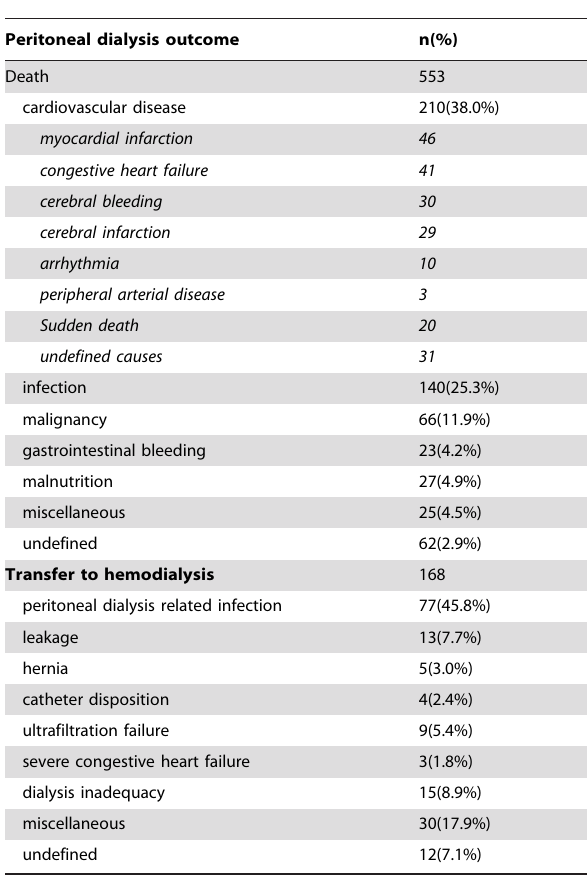
Table 3. Detailed clinical outcome of the study population.